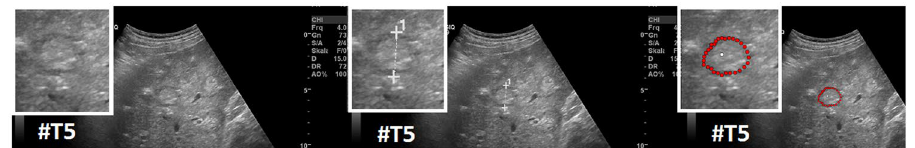
Figure 7. Segmentation results (manual/interactive) of a hyperechoic appearing metastasis with a hypoechoic halo (metastasis of a colon cancer), where the metastasis shows a very low contrast to the surrounding liver parenchyma. The native image with a zoomed view of the metastasis is presented in the left image. A manual measurement of the maximal metastasis diameter (white dotted line between two white crosses) is shown in the middle image. Finally, the rightmost image presents the interactive segmentation results (red dots) with the corresponding user-defined seed point (white). Note: figure adapted from 26